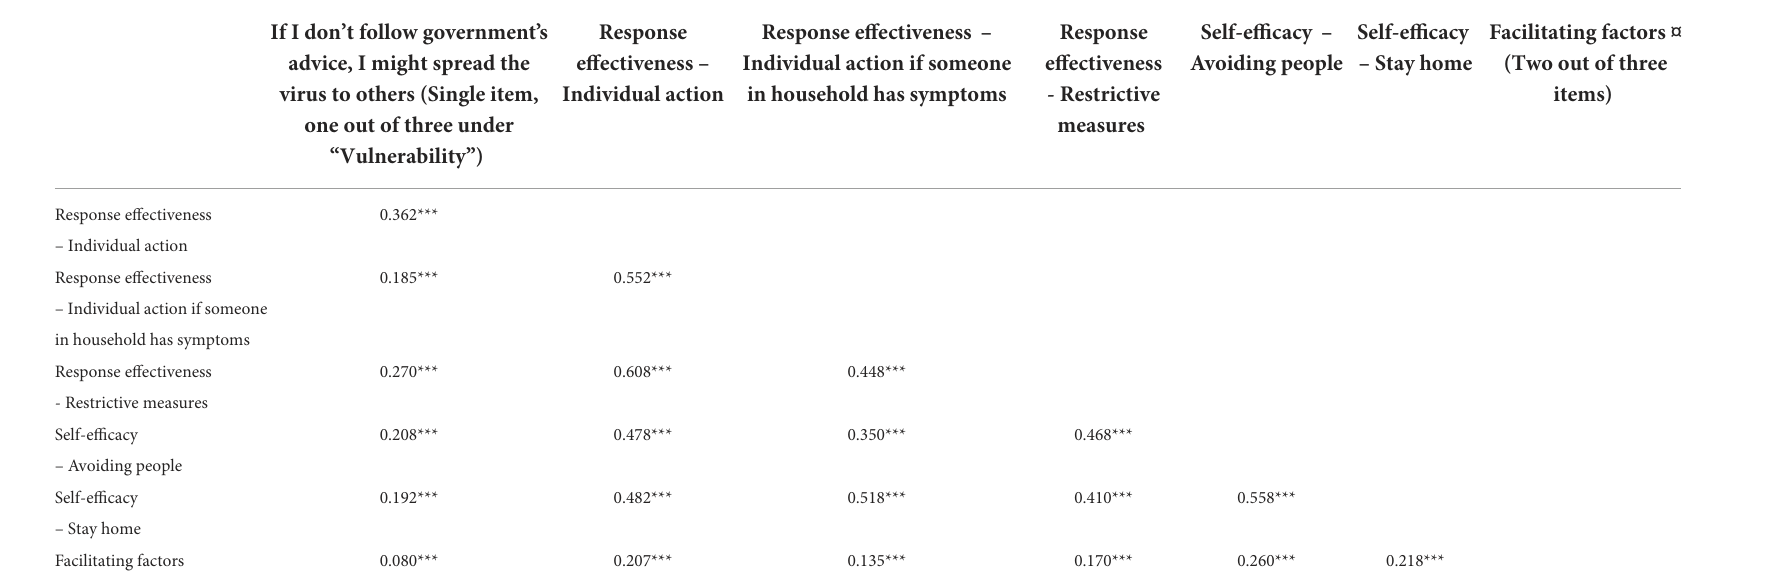
TABLE 5 Cognitive factors and facilitators and barriers – intercorrelations at Wave 1 ( n =